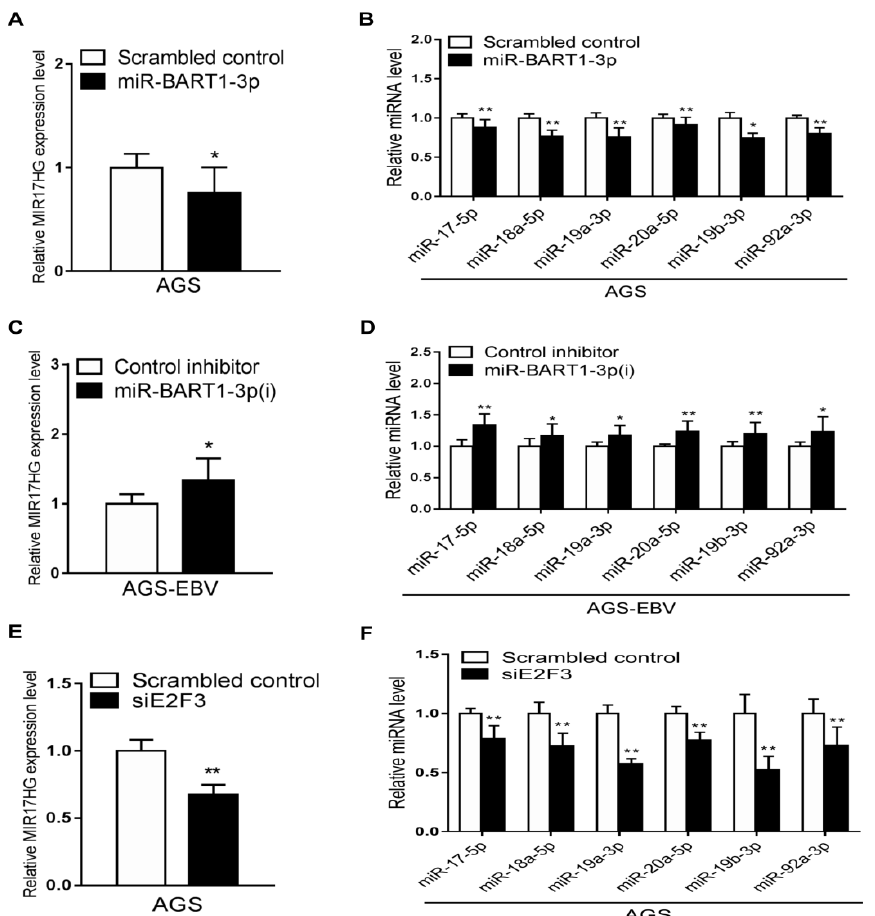
Figure 6. Effects of miR-BART1-3p and siE2F3 on miR-17-92 cluster miRNA expression. The AGS cells were transfected with 30 nM miR-BART1-3p mimic ( A ) and ( B ) or siE2F3 ( E ) and ( F ), while AGS-EBV cells were transfected with 30 nM LNA-miR-BART1-3p(i) ( C ) and ( D ). After 48 hr, the cells were harvested for RNA extraction. ( A ), ( C ), and ( E ) The expression of MIR17HG was measured by qRT-PCR. The MIR17HG expression was normalized to that of GAPDH and then expressed as a ratio compared with that of the control transfected cells. ( B ), ( D ), and ( F ) The qRT-PCR analysis of individual miRNAs encoded in the miR-17-92 cluster was carried out using a SYBR green qPCR kit. The expression of each miRNA was normalized to that of U6 and expressed as a ratio compared with that of the control transfected cells. The data were analyzed using Student’s t -test. Error bars indicate the SD ( n = 3). *, p < 0.05; **, p < 0.01.